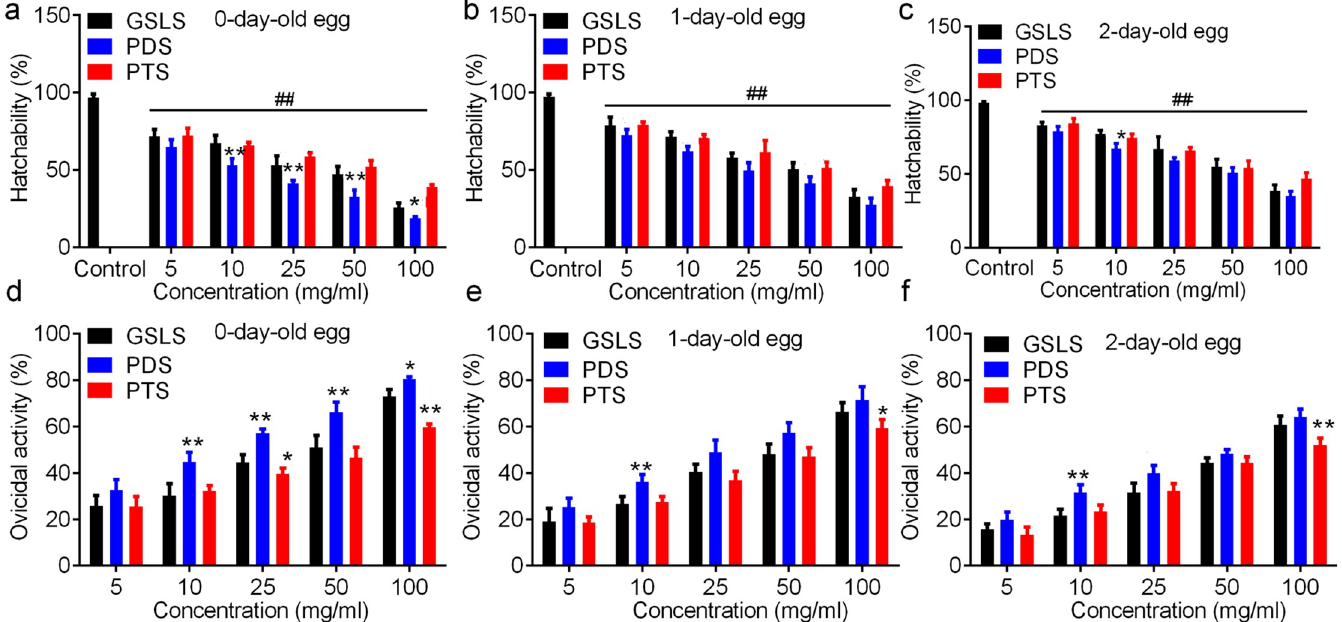
Fig 3. Hatchability and ovicidal activity of ginsenosides against O . furnacalis eggs. a-c, hatchability of O . furnacalis eggs treated with ginsenosides. d-f, ovicidal activity of GSLS, PDS, and PTS against O . furnacalis eggs at 0-day-old, 1-day-old and 2-day-old, respectively. � and �� notes p < 0.05 and 0.01 vs. total ginsenosides (GSLS) in each concentration, respectively. ## indicates p < 0.01 vs. control in Fig 3A–3C. Original data is listed in S1 Table. GSLS, total ginsenosides from of ginseng stems and leaves; PDS, panaxadiols saponins; PTS, panaxatriol saponins.